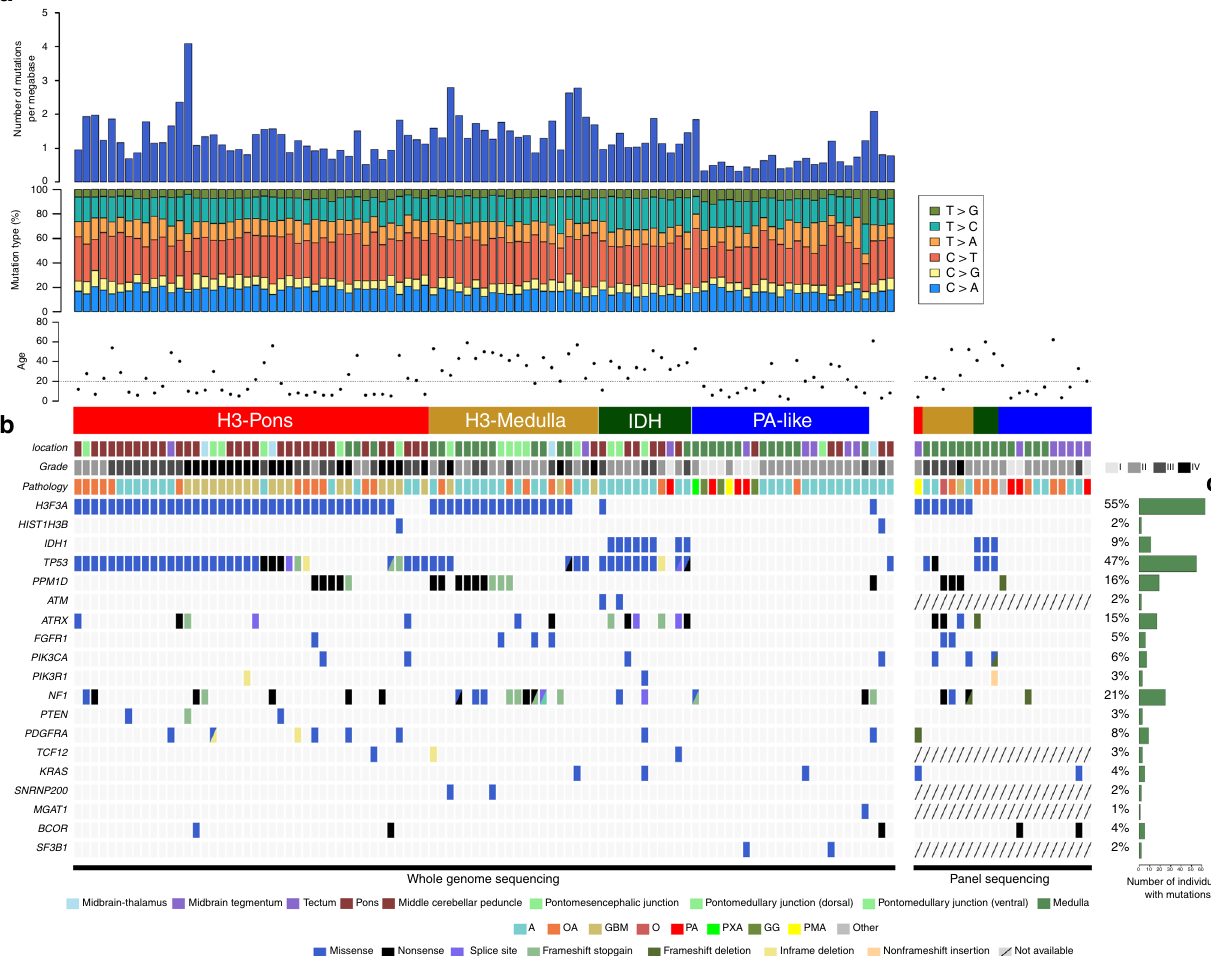
Fig. 3 Mutation landscape of brainstem glioma samples from whole genome sequencing data. a Numbers of mutations per megabase for each sample. b Clinical information and genetic alterations in brainstem glioma samples. c Frequency of mutations in each